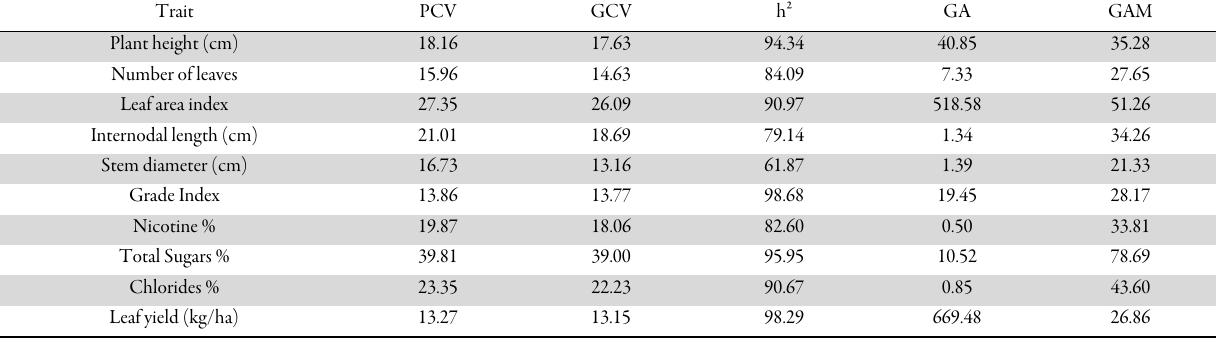
Table 1. Estimates of phenotypic coefficient of variation (PCV), genotypic coefficient of variation (GCV), heritability of broad sense (h ²) , Genetic advancement (GA) and percentage of GA Mean in MAGIC-F2 population Trait PCV GCV h² GA